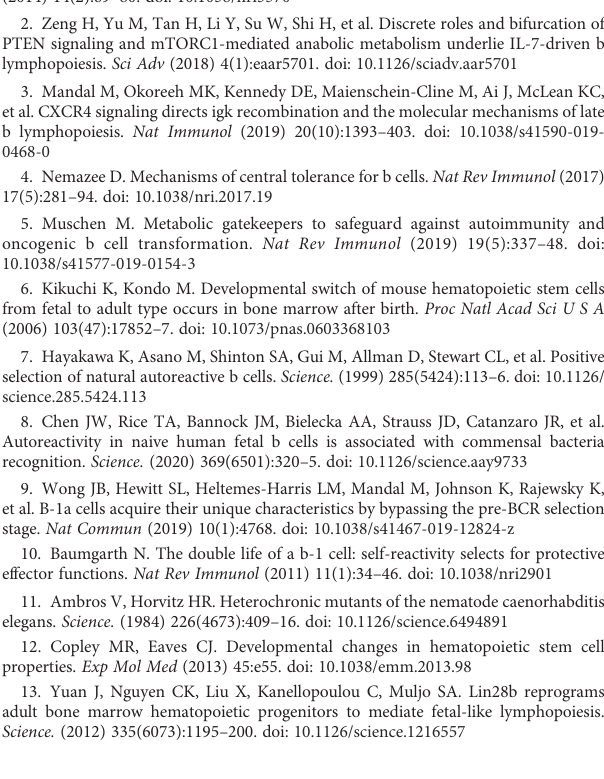
Antibodies and reagents used for Flow Cytometry, Western Blot, or